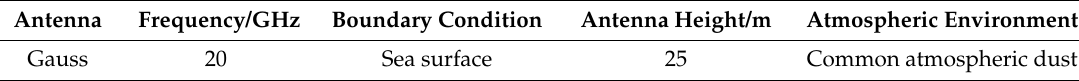
Table 1. The simulation conditions of atmospheric